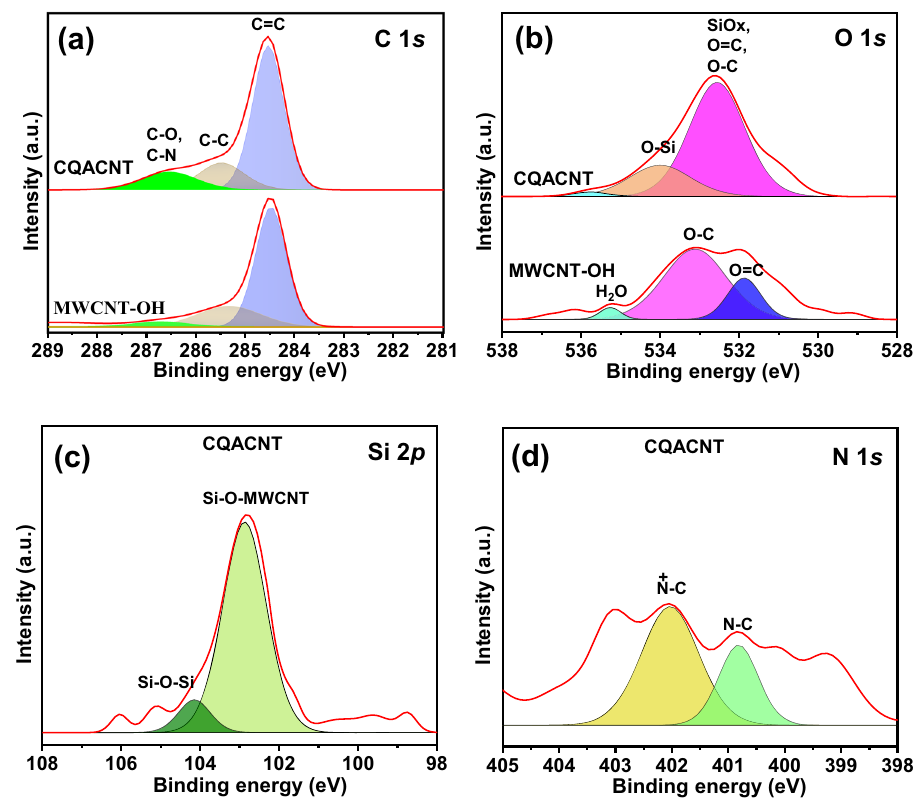
Fig. 2 High-resolution XPS spectra of MWCNT-OH and CQACNT. a C 1 s ; b O 1 s ; c Si 2 p ; d N 1 s